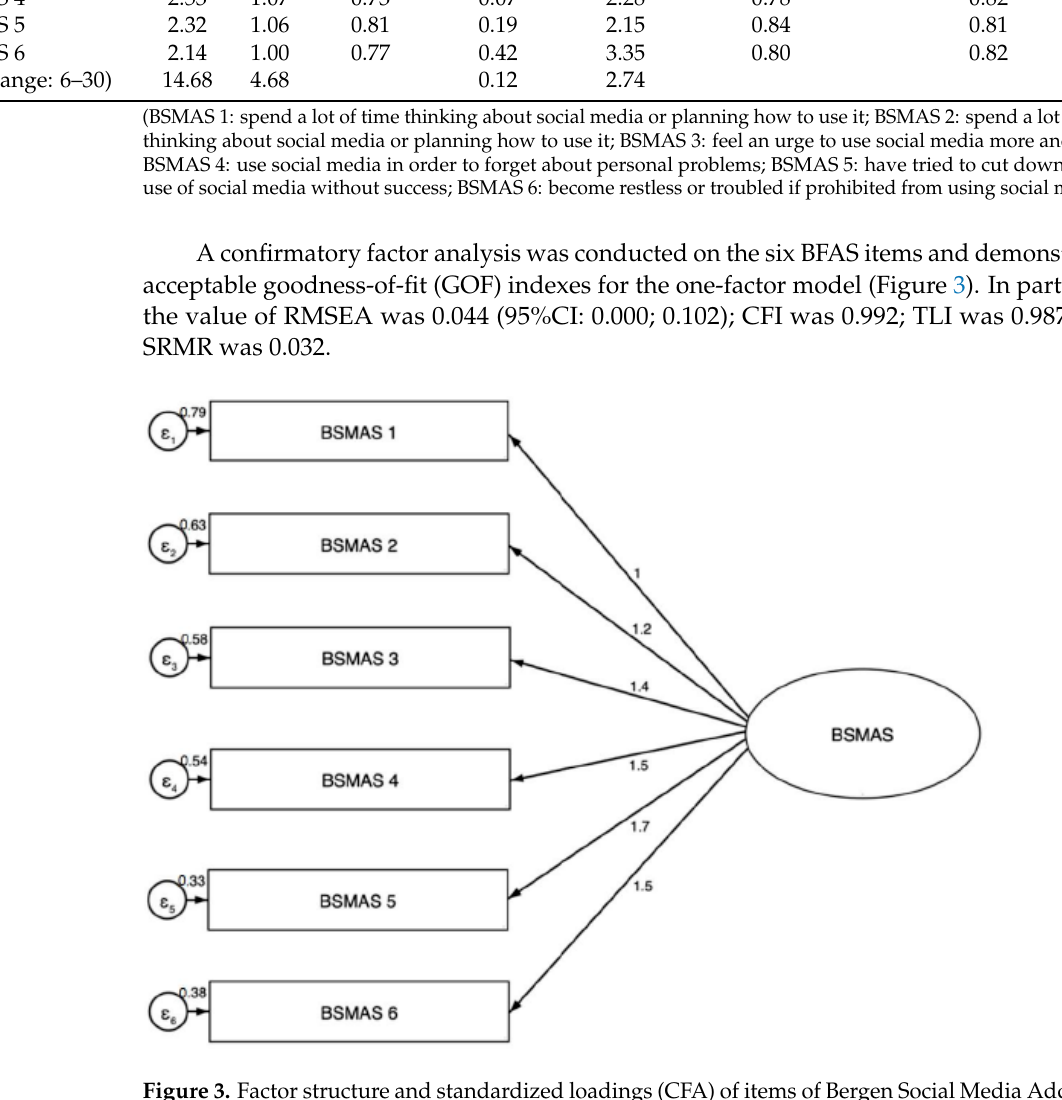
Figure 2. Scree parallel plot. Table 3. Basic descriptions and reliability of Bergen Social Media Addiction Scale (BSMAS).